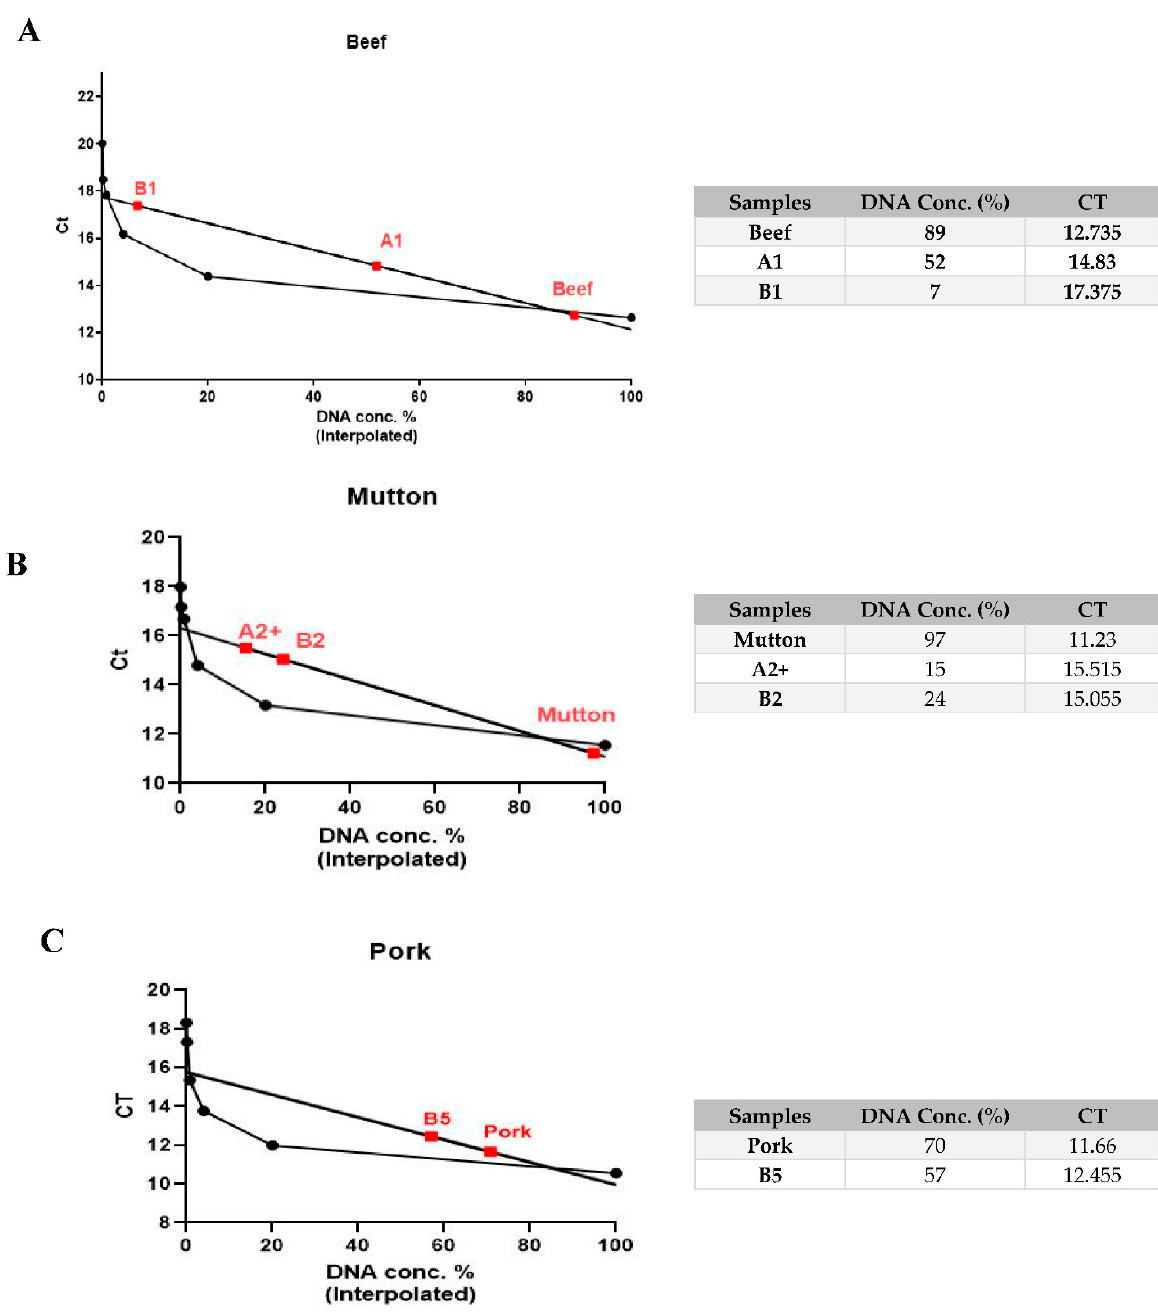
Figure 4. A. The calibration curves of ( A ) beef, ( B ) mutton, and ( C ) pork DNA samples. The amounts of DNA in each meat sample were calculated according to the related calibration curves, and are illustrated as red symbols on the curves. The obtained amounts of each meat species are presented in tables.